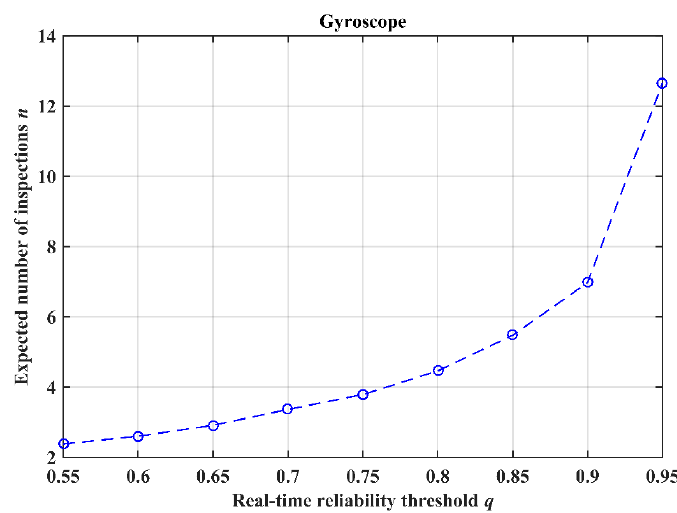
Figure 6. Total expected number of inspections versus the real-time reliability threshold 𝑞 at 𝑤 (cid:2868) = 0.58( ° /h) .